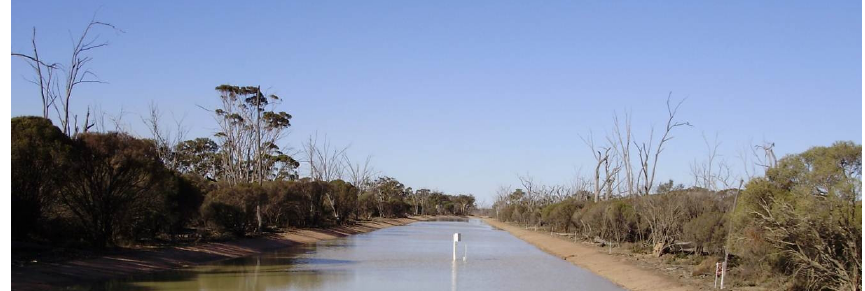
Figure 2. New broad-based channel implemented in the Dulbinning Nature Reserve. Channel dimensions at this location are 23m wide and 0.55m deep. Water depth in this image is